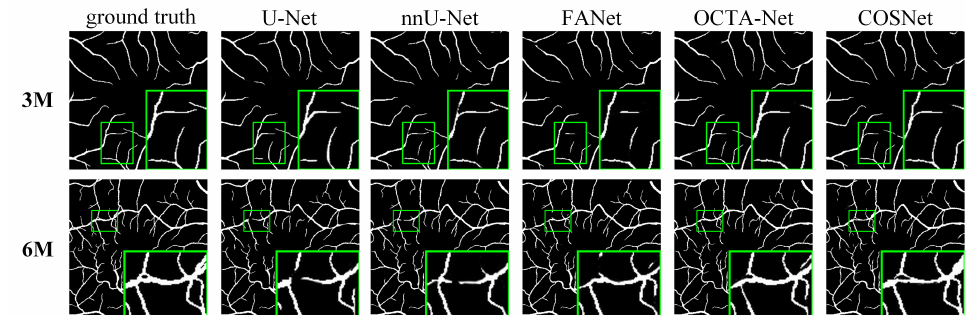
Figure 8. Segmentation results for OCTA-500 (ILM-OPL).